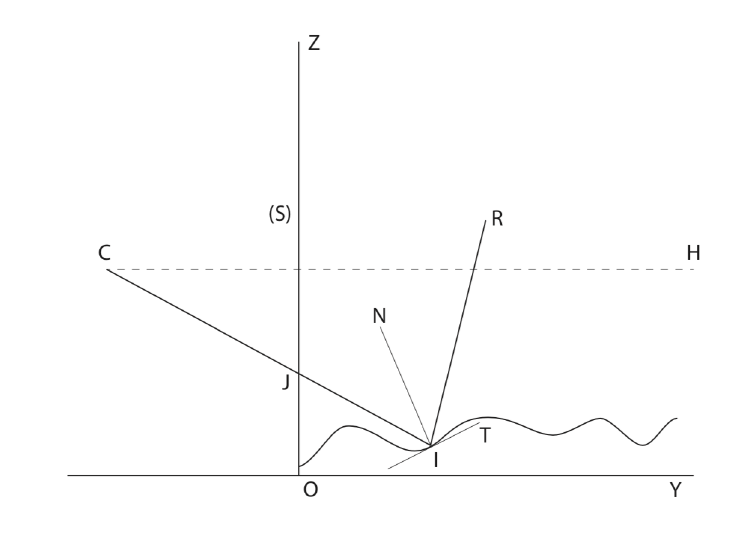
FIG. 1: Impression, soleil levant, Monet (1872)